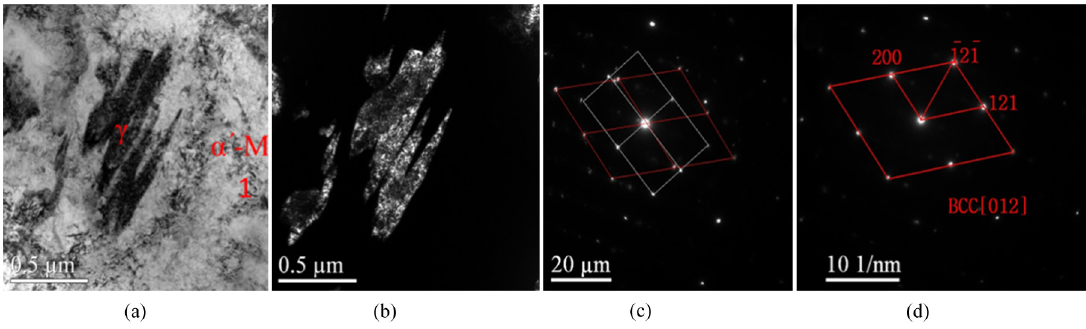
Figure 6. TEM micrographs of 5µm Fe-7.9Mn alloy powders (a) bright, (b) dark field electron image, (c) SADP of austenite, (d) SADP of matrix (marked as 1 in